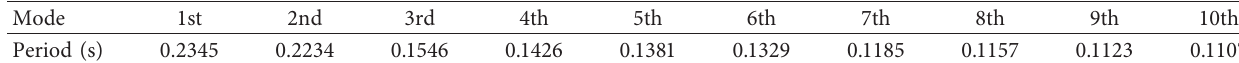
Figure 2: Finite element model of the nuclear island structure. (a) Model composition. (b) Whole model. (c) Three views. Table 1: First ten modes of CAP1400 nuclear island structure.